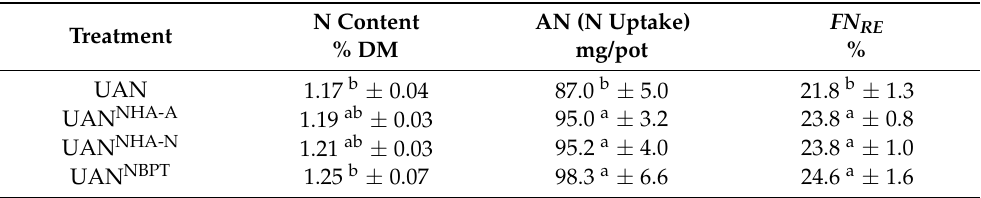
Table 2. The effect of the UAN fertilizer with NHAs and NBPT on the content of N in AGB of maize, nitrogen uptake (AN) and fertilizer N recovery ( FN RE ). N Content AN (N Treatment % DM